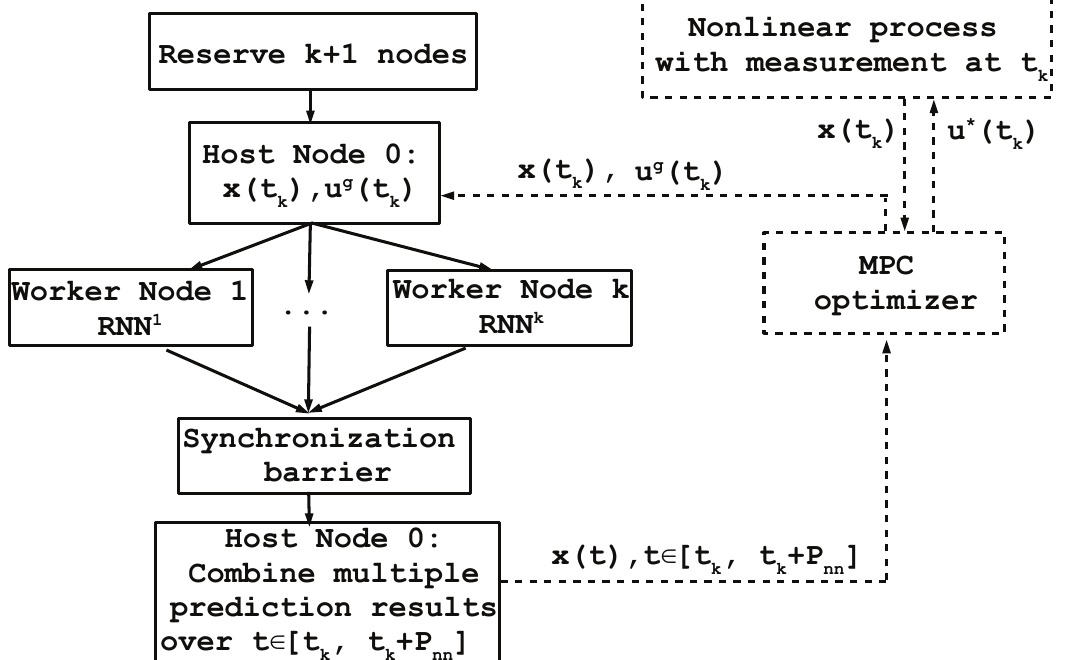
Figure 3. Algorithm for parallel computation of an ensemble of k RNN models, where x ( t k ) is the state measurement, u g ( t k ) is the initial guess of manipulated inputs provided by the MPC optimizer, and u ∗ ( t k ) is the optimal control action sent to the nonlinear process of Equation (1),